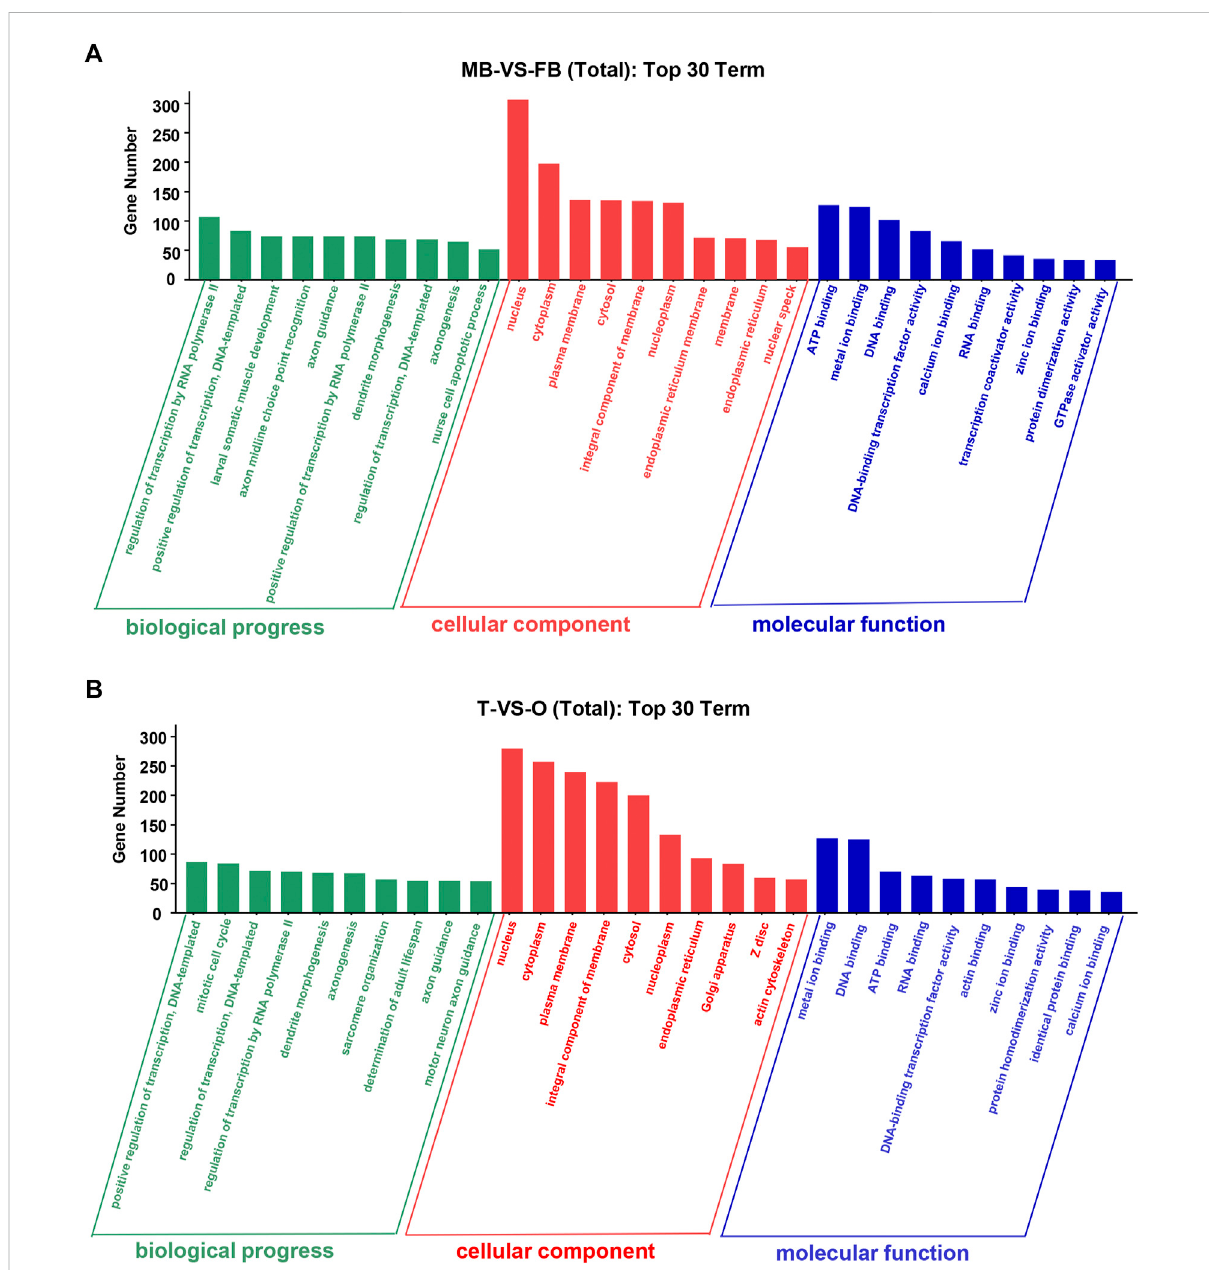
FIGURE 3 Top 30 GO terms of unique genes targeted by DEMs from the female and male macrobrachium rosenbergii in the brain (A) and gonad (B) . GO analysisfallsintothreecategories:biologicalprocesses,molecularfunctions,andcellularcomponents. MB:malebrain;FB:femalebrain;T:testis;O: